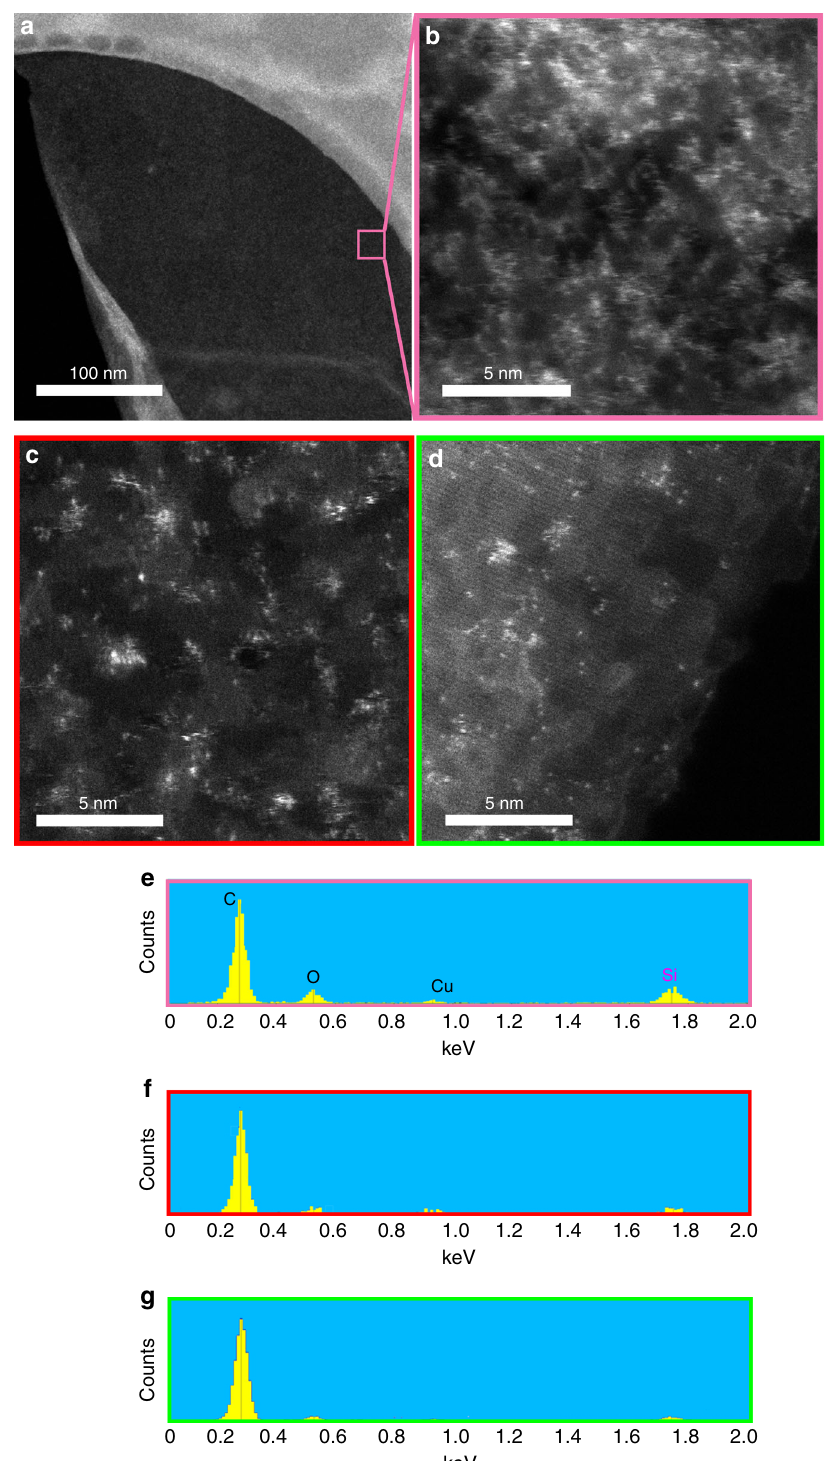
Fig. 5 The effect of washing on typical graphene oxide derived from low-purity graphite (98% purity). a , b GO washed with 5 M NaOH at 120 °C. a Restacked GO sheets due to the basic washing. b Detail of the boxed region in a showing that the silicon-rich impurities have become more dispersed but have not been removed. c Chemically reduced GO showing the silicon-rich contamination. d NH 4 F washed GO. The surface appears cleaner, but this treatment also causes signi fi cant agglomeration and restacking of sheets. e – g A comparison of the EDS spectra of the NaOH washed, chemically reduced and NH 4 F washed GO in b – d ,